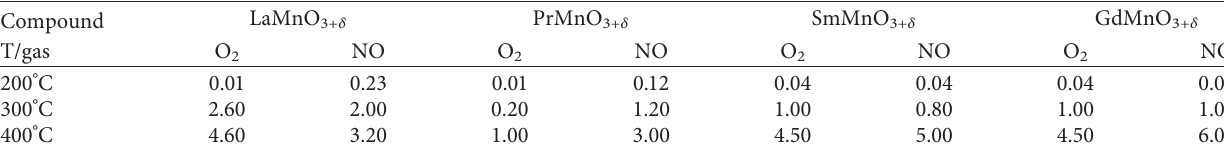
Figure 7: At 400C, the voltammograms recorded on the four manganite-based perovskites in 1% NO in Ar are becoming more similar. The voltammograms are recorded with a sweep rate of 1mV/s. It is noteworthy that the downward bend of the voltammograms recorded on the SmMnO 3+ δ and GdMnO 3+ δ perovskites at low potentials is more pronounced than that on the LaMnO 3+ δ and PrMnO 3+ δ perovskites. Table 2: Maximum cathodic current densities in oxygen- and nitric oxide-containing atmospheres for the four manganite-based pe- rovskites, given in mA/cm 2 . The current densities increase with increasing temperature. The apparent selectivity for the reduction of nitric oxide is highest for the LaMnO 3+ δ perovskite at 200 ° C.